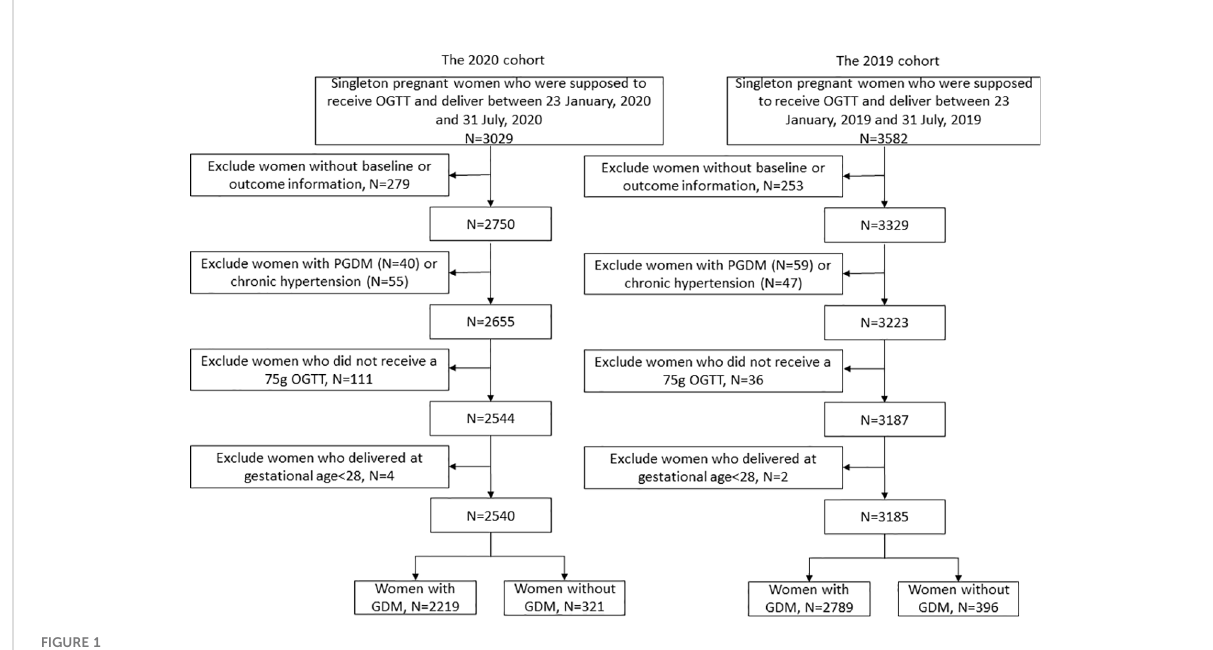
FIGURE 1 Study fl ow